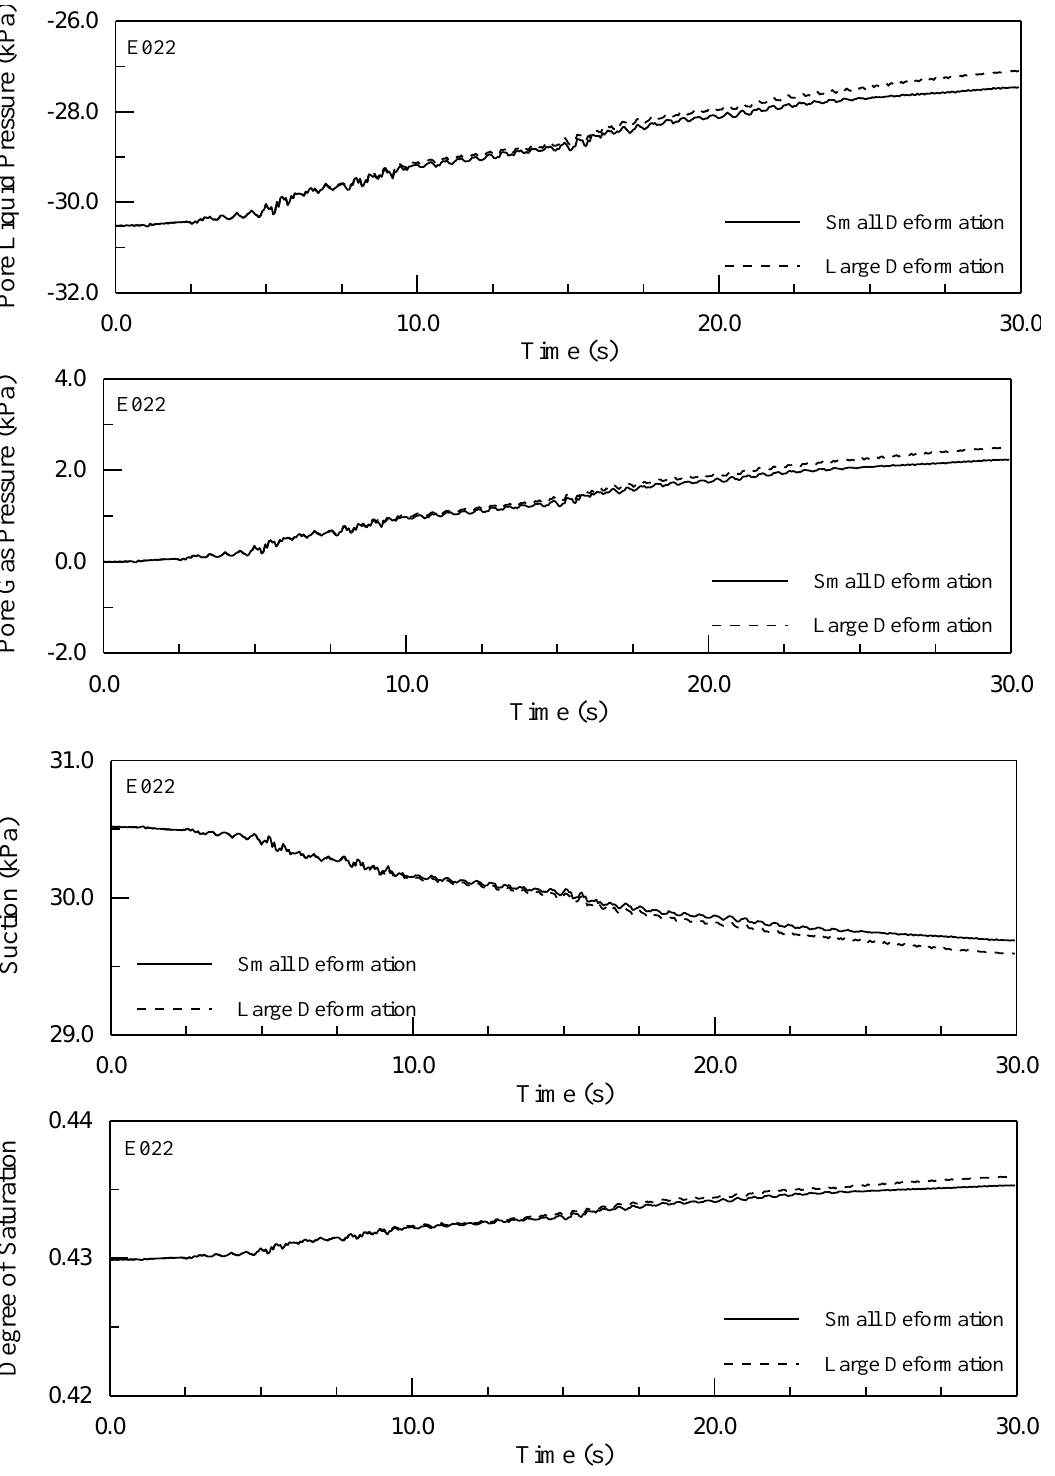
Figure 10. Fluid pressures, suction, and the degree of saturation – time histories at element E022.